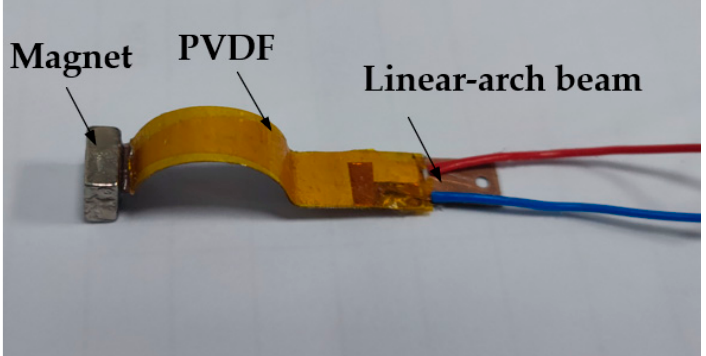
Figure 10. Linear-arch piezoelectric energy harvester.